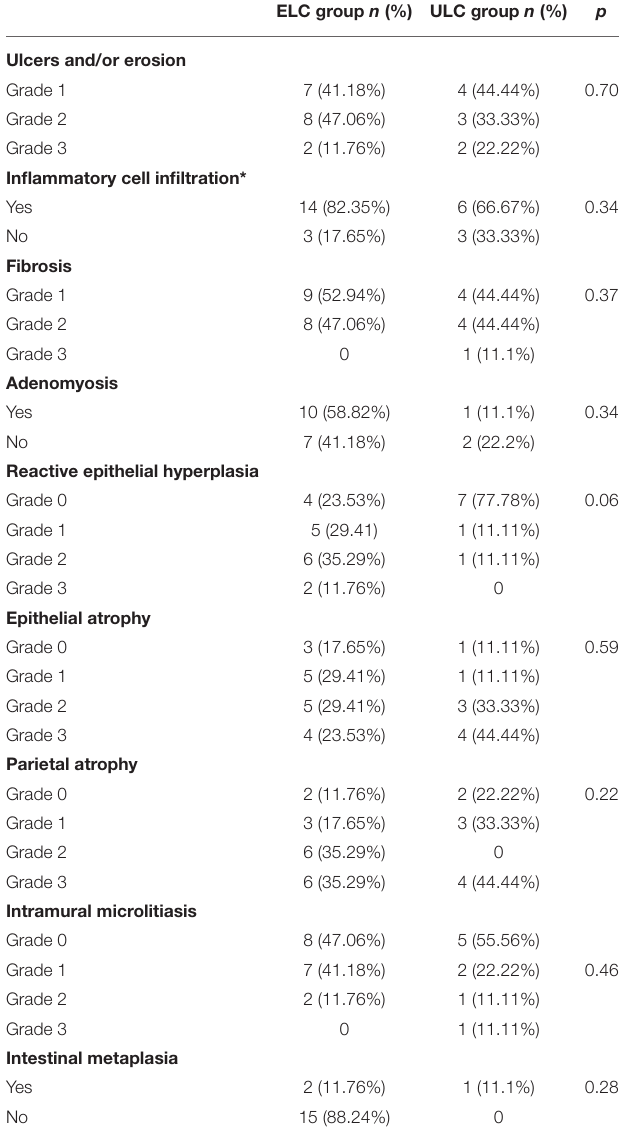
TABLE 5 | Histological features in the Elective Laparoscopic Cholecystectomy (ELC) and Urgent Laparoscopic Cholecystectomy (ULC)